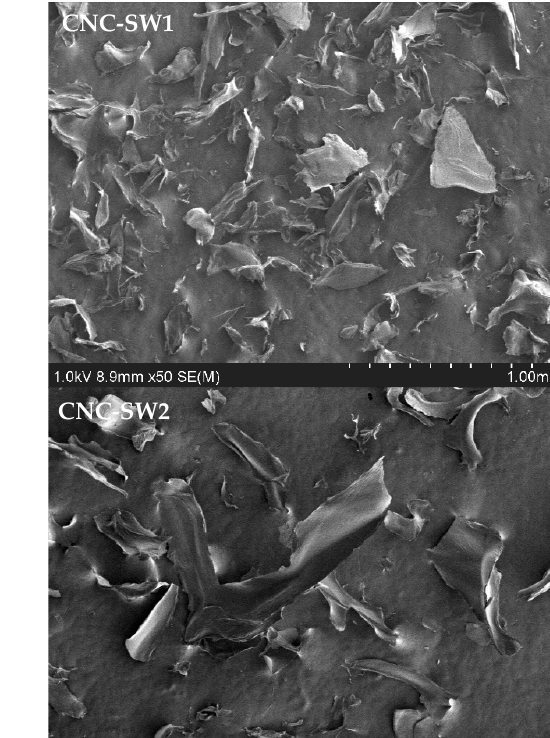
Figure 13. SEM images of CNC from HW and oxidized HW.